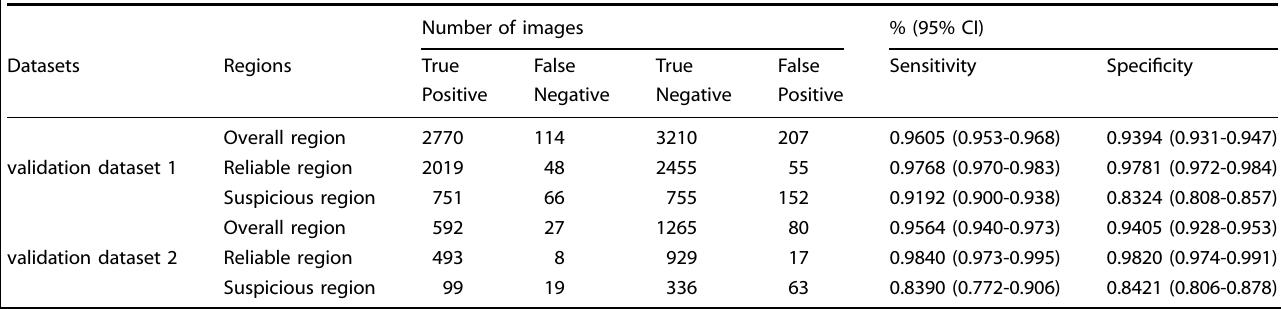
Table 2. Performance of the hierarchical deep learning system in different con fi dence regions on validation datasets 1 and 2.